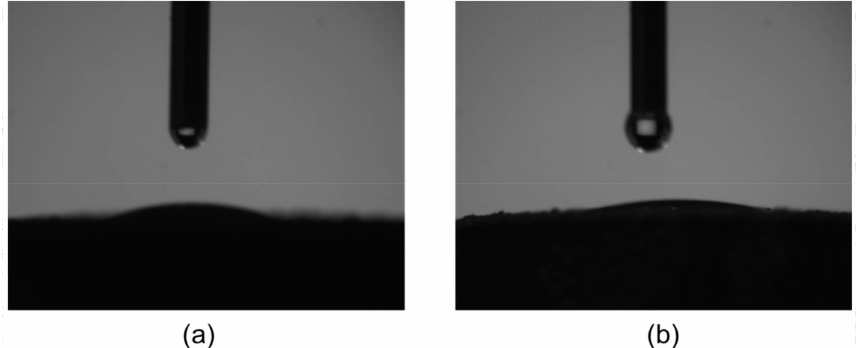
Figure 5. The contact angle measurement of MT ( a ) and MNT ( b )